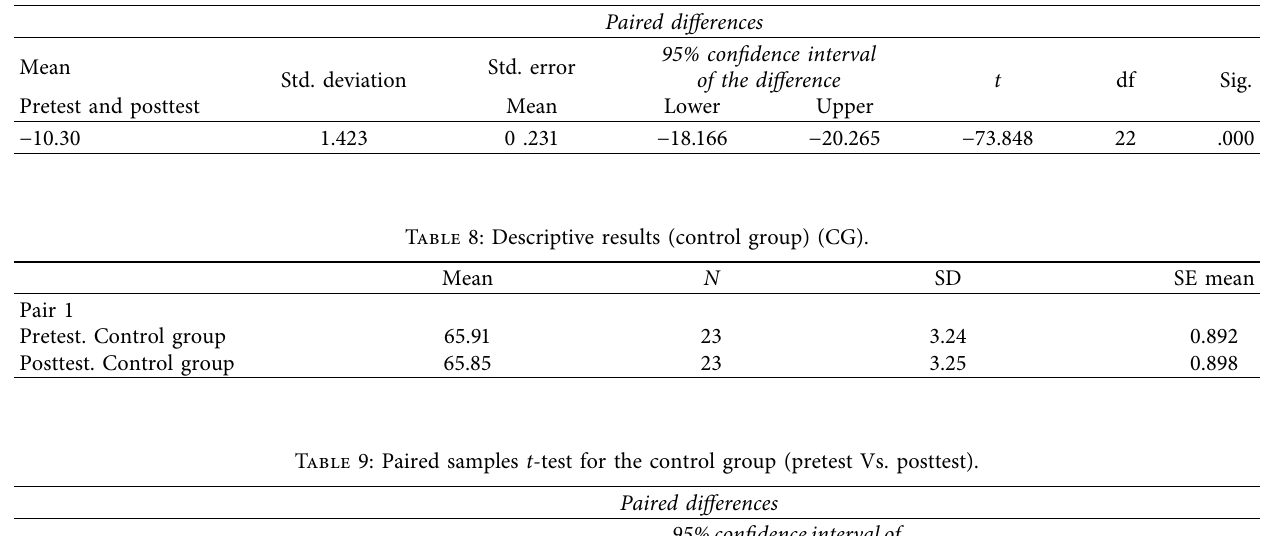
Table 7: Paired Samples t -test of the experimental group (pretest Vs. posttest).